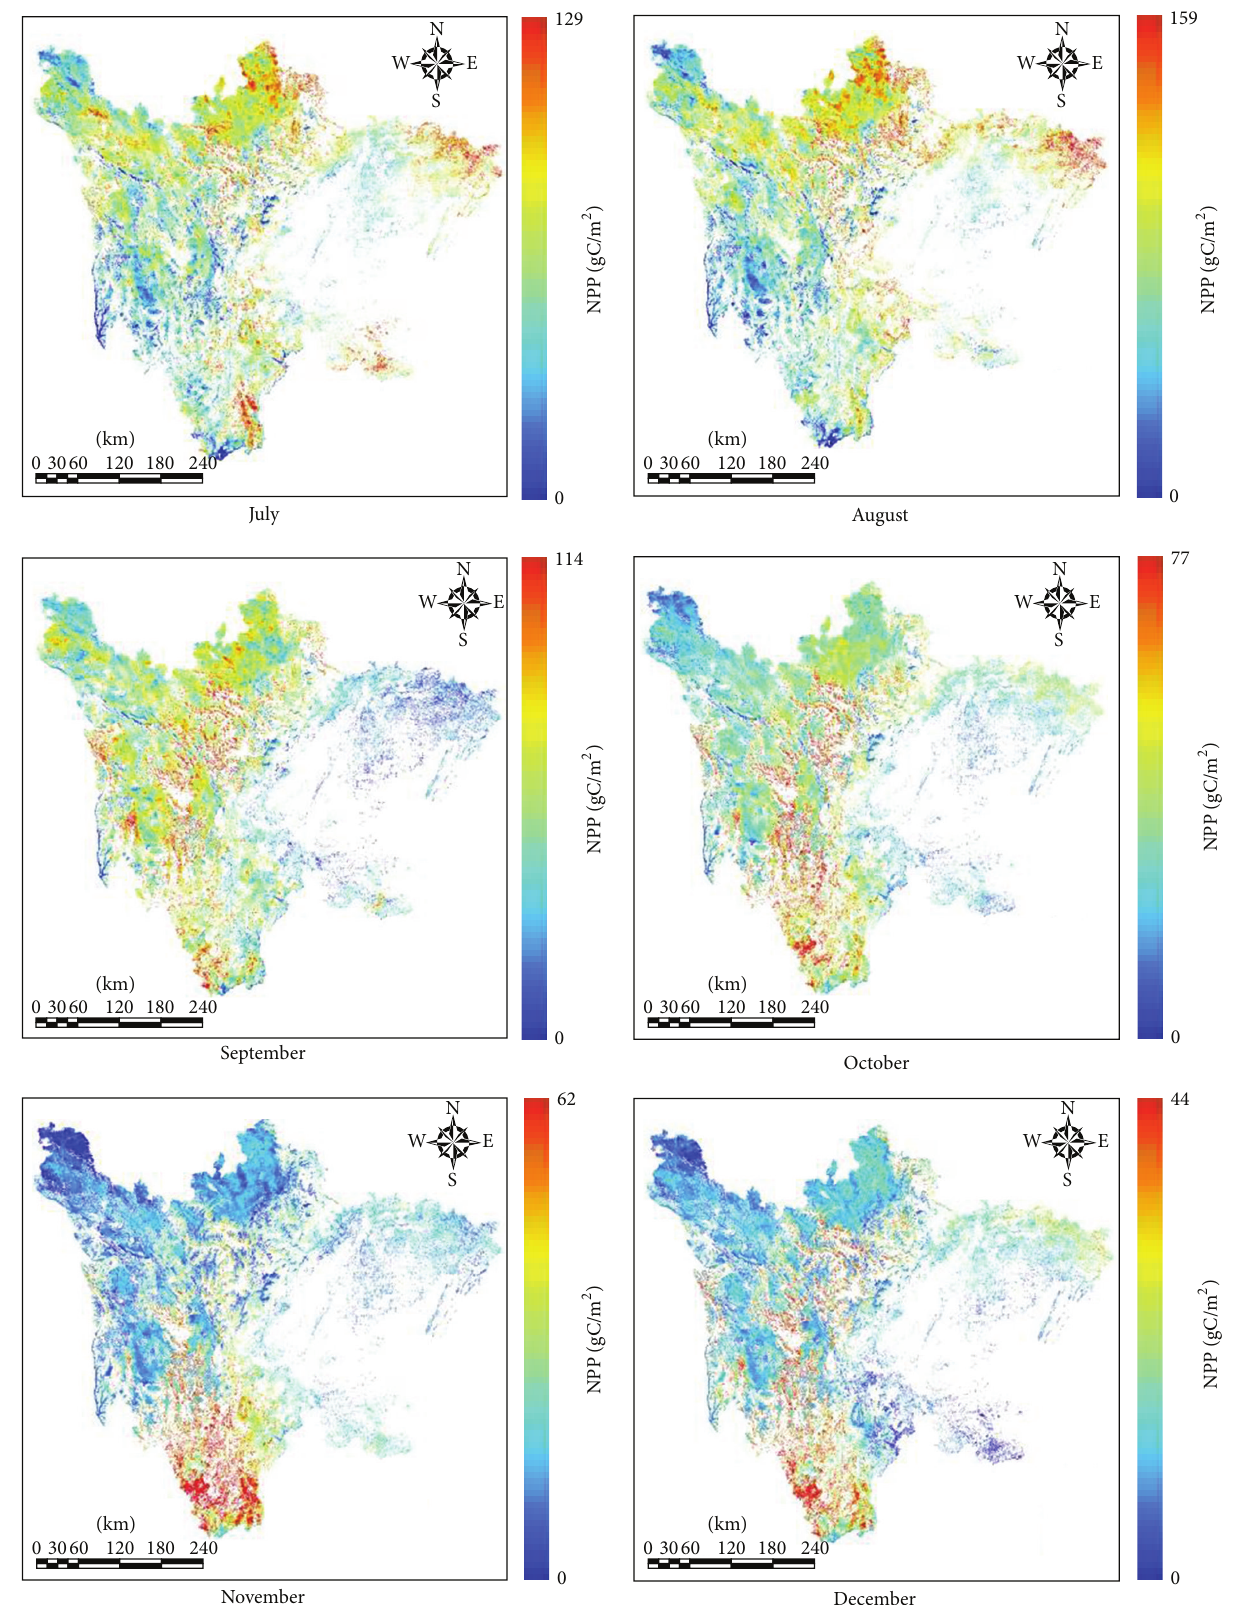
Figure 7: Distribution of NPP for Sichuan grassland for each month of